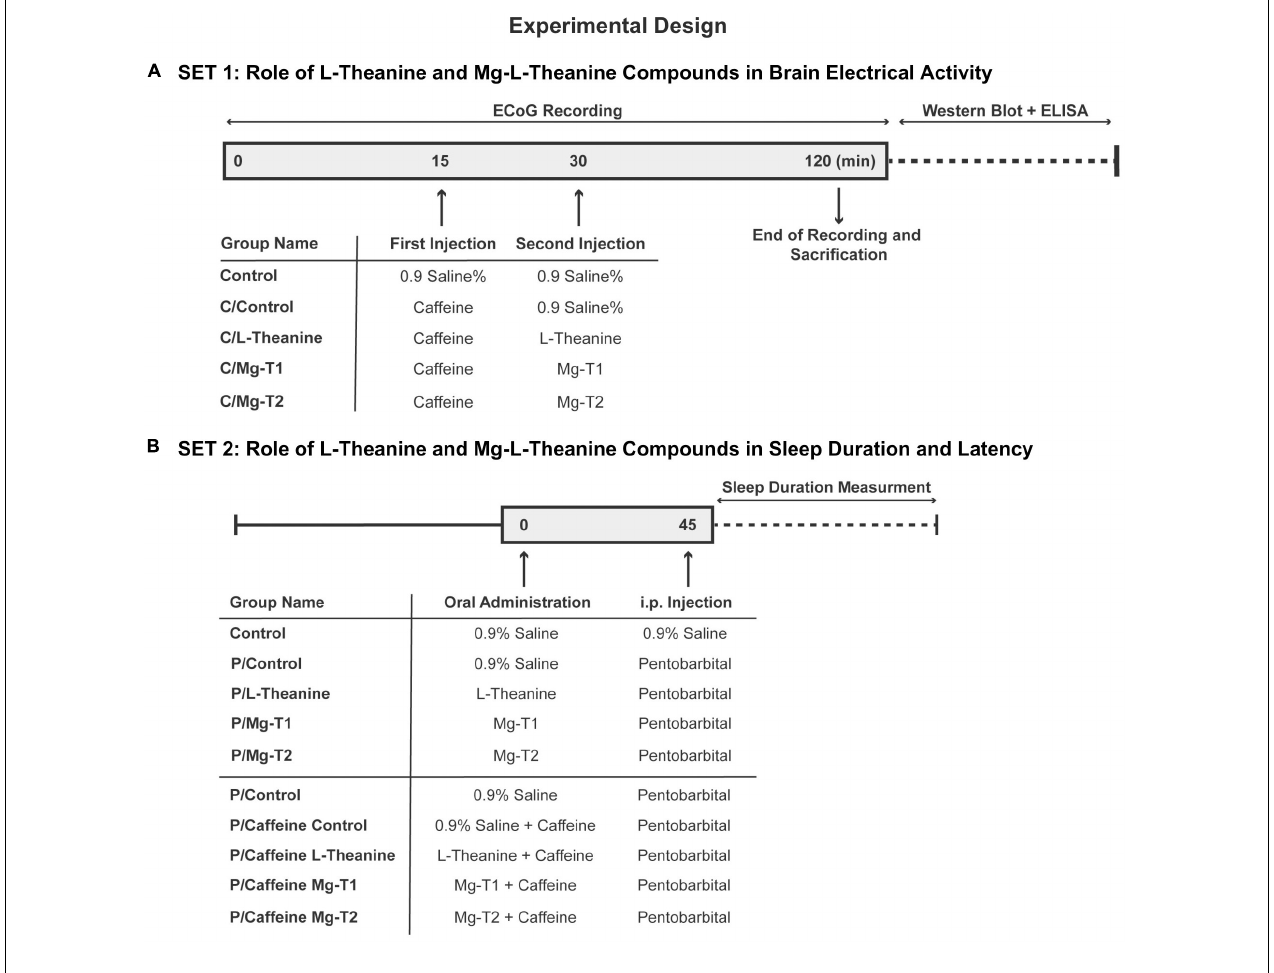
FIGURE 1 | Experimental design. Experimental design and animal groups, n = 6 for the first set (A) , n = 8 for the second set (B) .